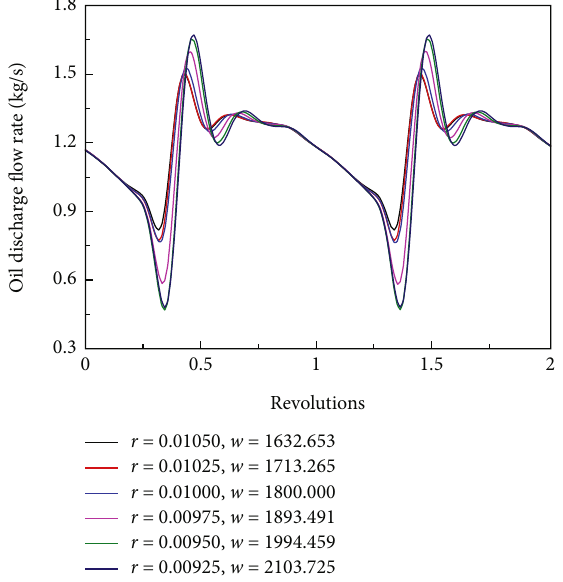
Figure 19: The fl ow rate curves of the outlet port with di ff erent plunger chamber radii and rotation